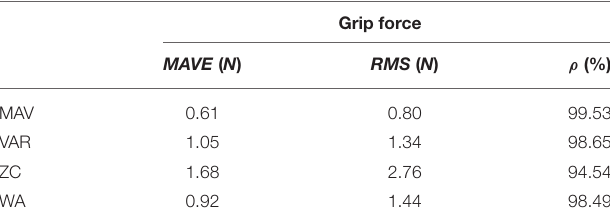
TABLE 4 | The average results of the grip force estimation experiments across all the subjects.